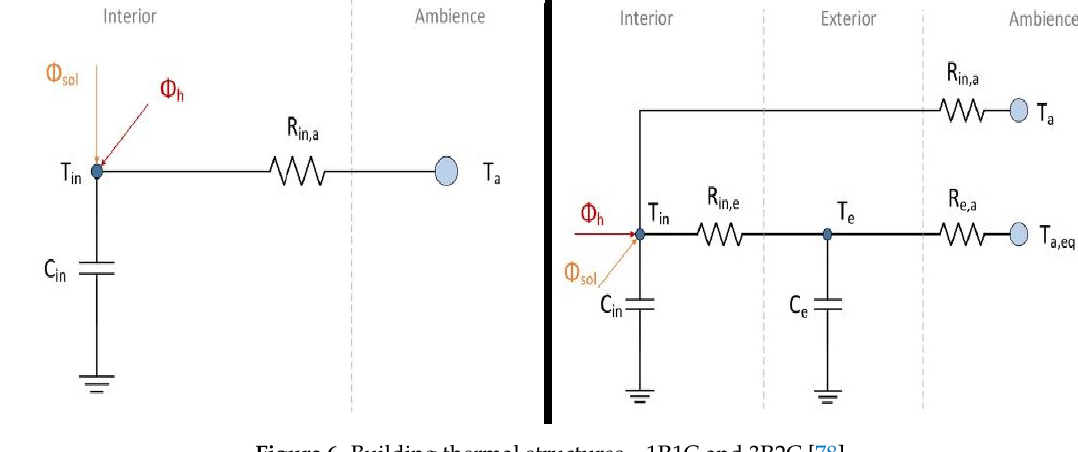
Figure 6. Building thermal structures—1R1C and 3R2C [78].